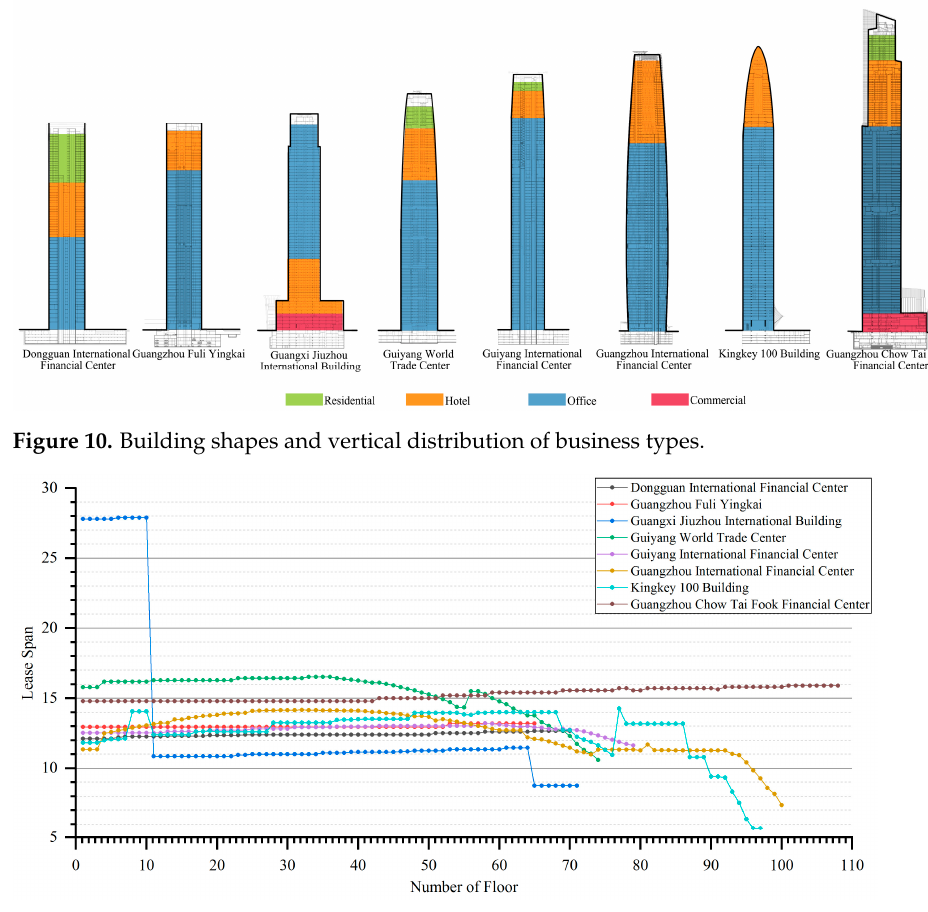
Figure 12. Variation of the core area of the typical floor.